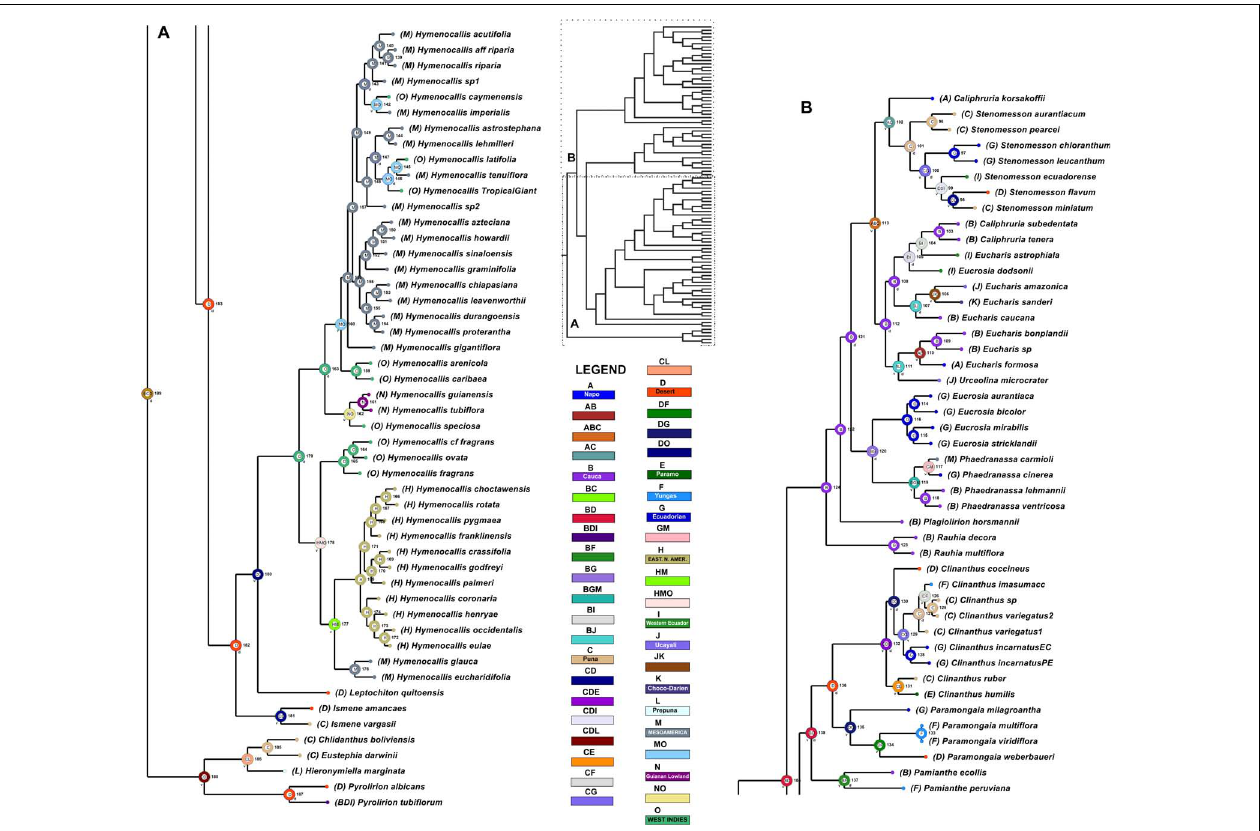
FIGURE 10 | Area cladogram generated by Divalike+J analysis with BioGeoBears through RASP 4.2, using the best tree found by maximum likelihood of the 90% taxon coverage supermatrix with RAxML. Areas at any node were limited to three, and only the most likely was mapped onto the tree. Lower case “v” and “d” adjacent to a node = vicariance or dispersal, respectively. The tree is divided into two sections (A,B) for readability; refer to the inset as a guide.